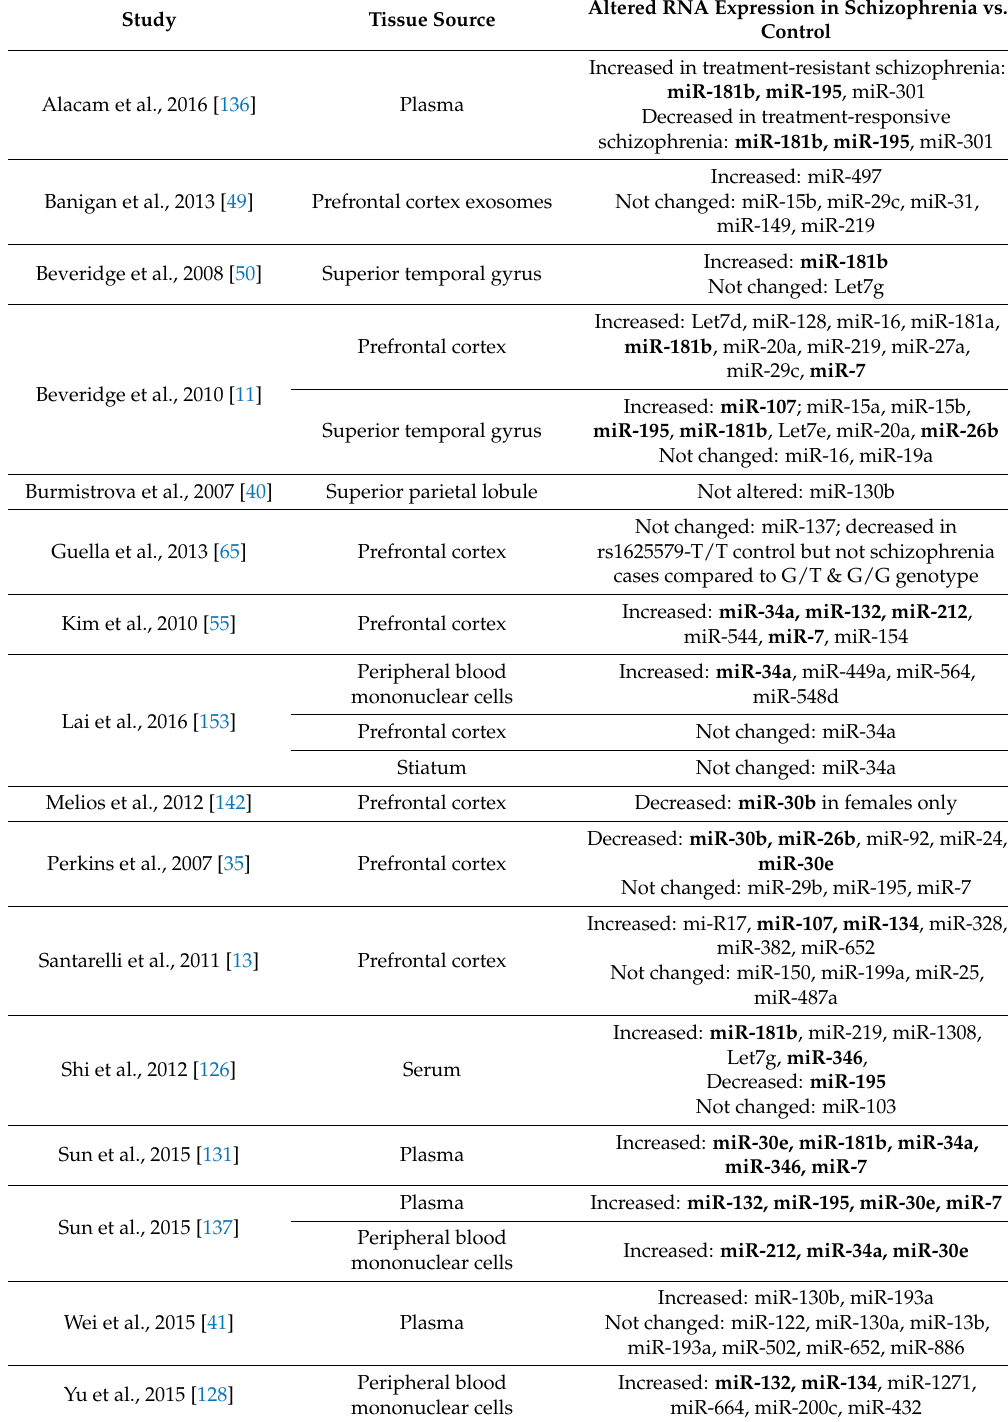
Table 1. A summary of microRNA (miRNA) expression studies showing the range of different miRNA reported as differentially expressed in schizophrenia. MicroRNA in bold are reported to be altered in more than one